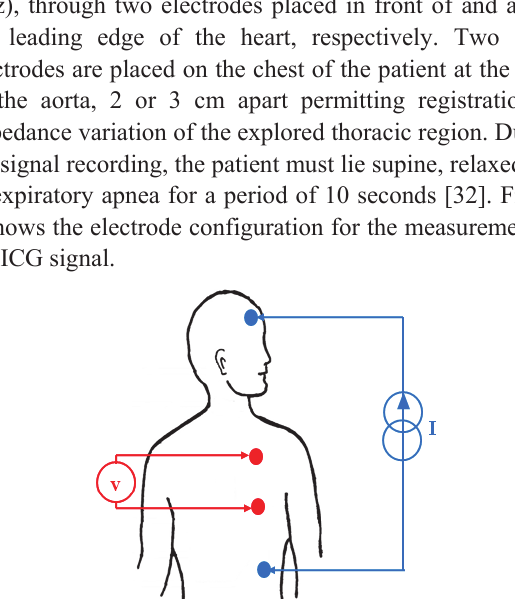
Fig.1: Electrodes configuration for the measurement of the ICG signal.